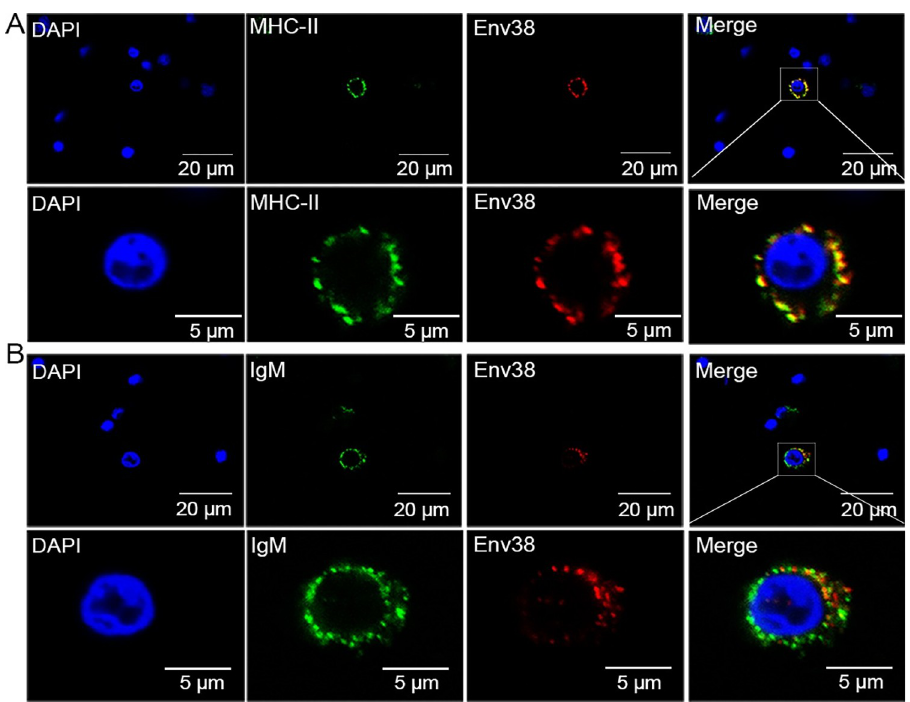
Fig 4. Double immunofluorescence staining of MHC-II + Env38 + APCs in leukocytes of zebrafish. The leukocytes were sorted from spleen, head kidney and peripheral blood of zebrafish stimulated with SVCV (10 5 TCID 50 ). (A) Cells were labled with mouse anti-Env38 and rabbit anti-MHC-II α Abs, followed by Alexa Fluor 594-conjugated goat anti- mouse IgG and FITC-conjugated goat anti-rabbit IgG. (B) Cells were labled with mouse anti-Env38 and rabbit anti- IgM Abs, followed by Alexa Fluor 594-conjugated goat anti-mouse IgG and FITC-conjugated goat anti-rabbit IgG. DAPI stain showed the location of the nuclei. Fluorescence images were captured using a Laser scanning confocal microscope (FV3000) with 60 × oil